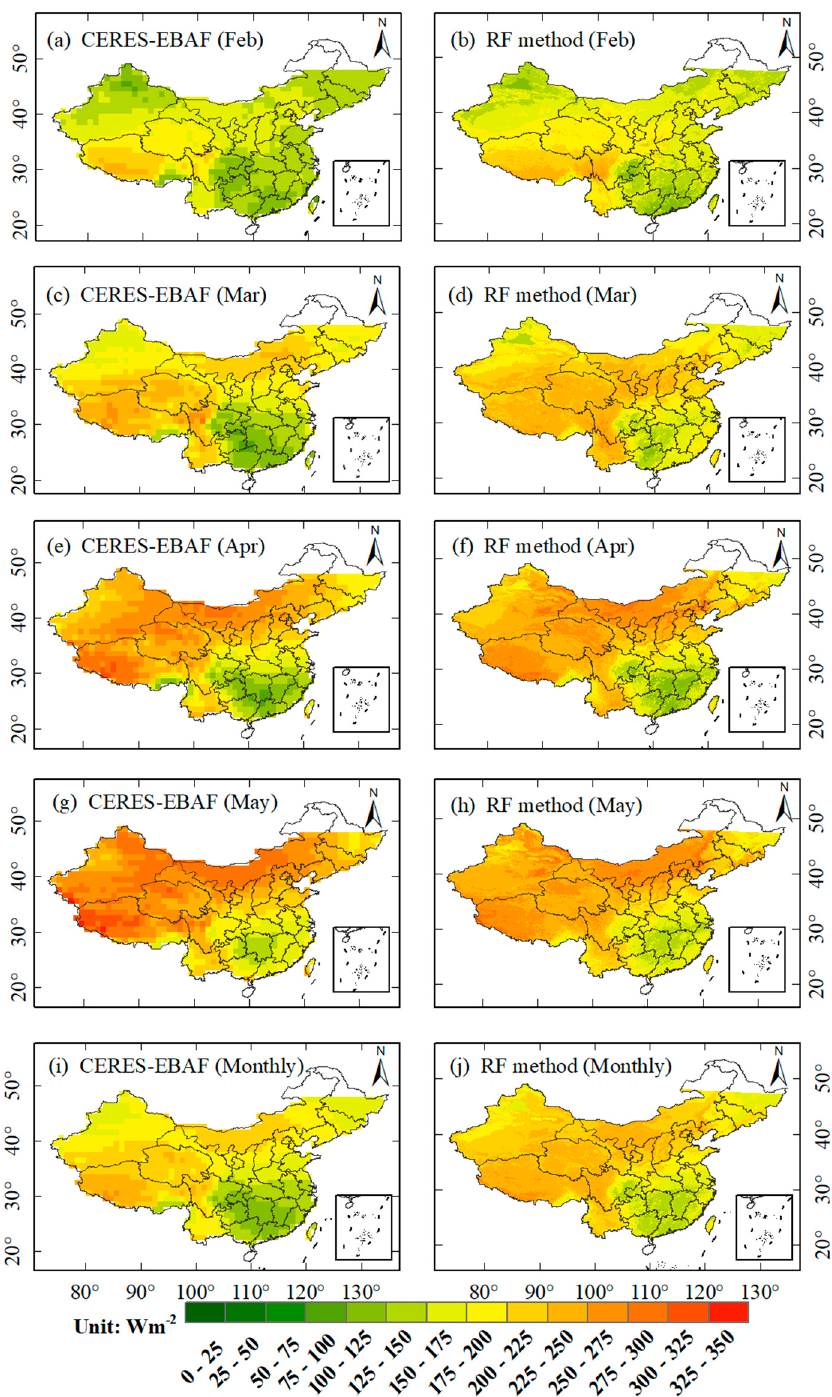
Figure 10. The spatial distribution of the monthly mean estimated R S data over China of CERES–EBAF and the RF method from February to May 2016: panels ( a – h ) for each month; ( i , j ) for monthly mean R S from February to May.